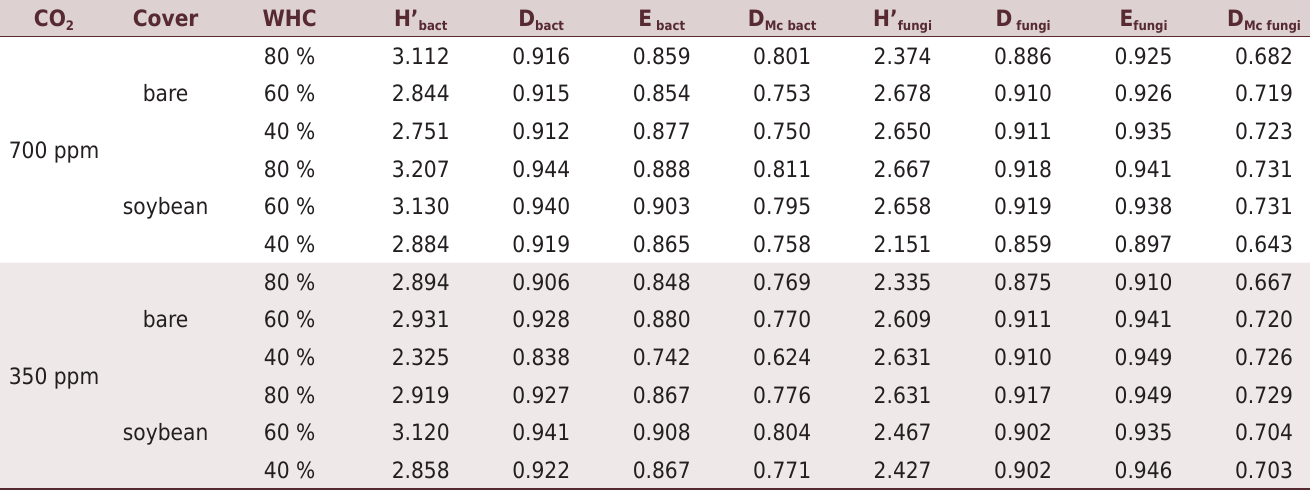
Table 2. Relative abundance and diversity indices calculated from the DGGE pattern of soil bacterial and fungal community under different treatment of soil moisture, elevated CO 2 level, and soil cover (with or without Glycine max plant) CO 2 Cover